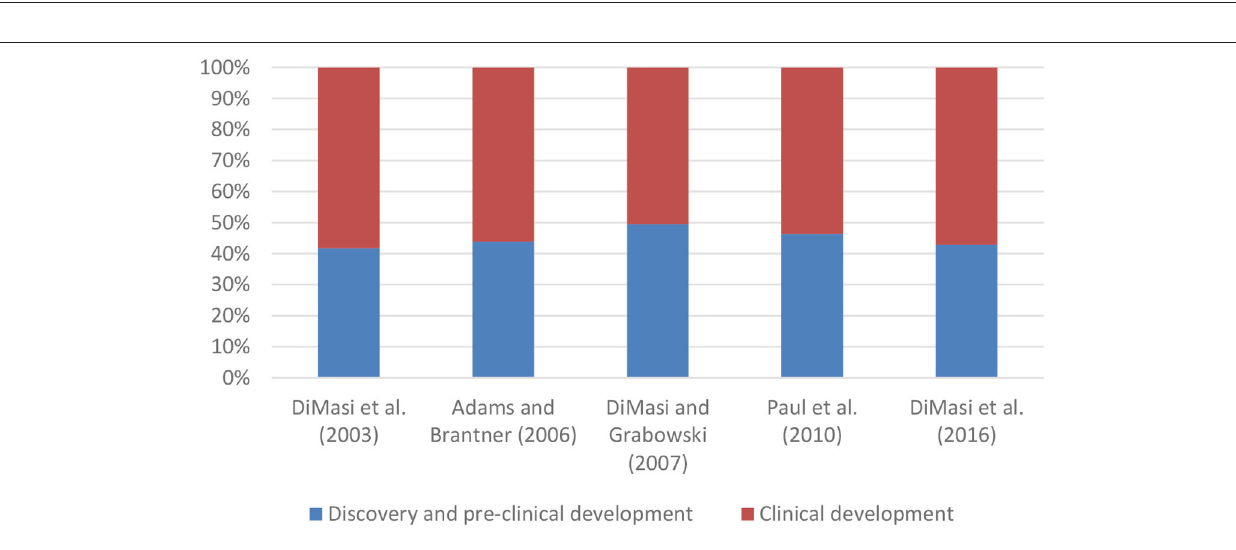
FIGURE 2 | Composition of mean capitalised R&D costs per new medicine. DiMasi and Grabowski (8) selected a sub-sample of biotechnology medicines from DiMasi et al.